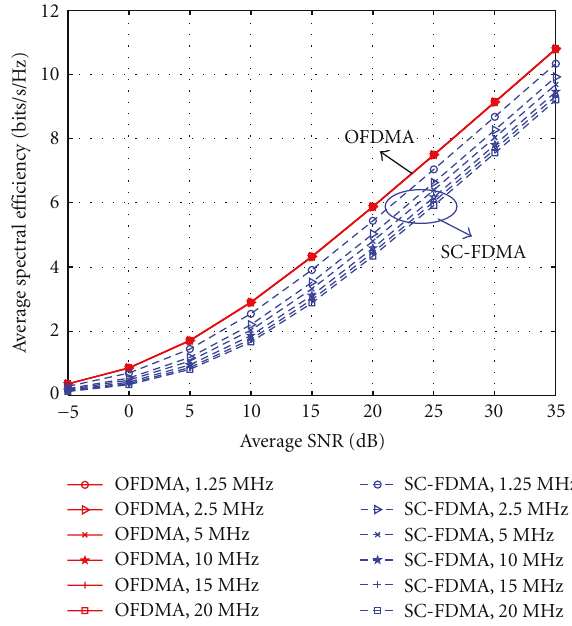
Figure 4: Comparison of the achievable information rate between OFDMA and SC-FDMA for di ff erent bandwidths under di ff erent average receive SNR conditions in the SCME “urban-macro” scenario with a single user in the system.